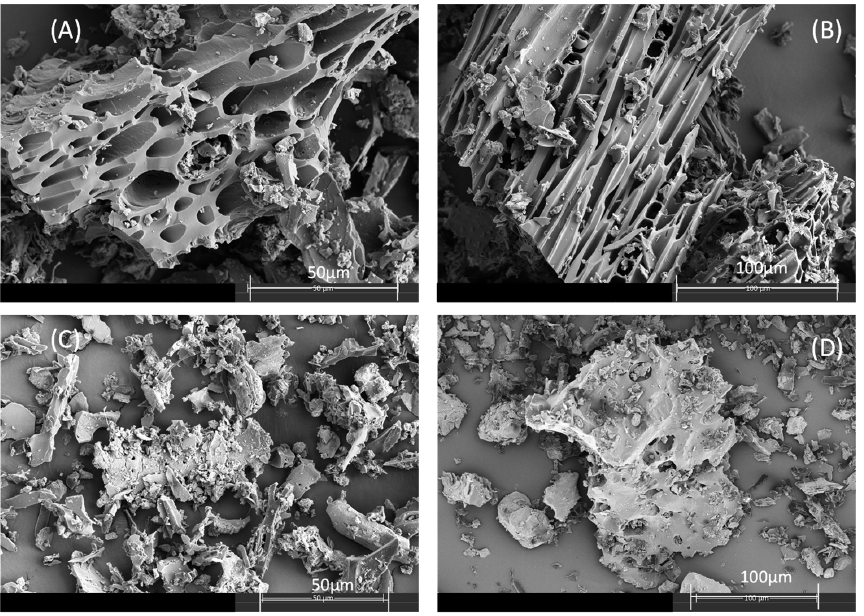
Figure 1. SEM visualization of individual biochar sample, ( A ) and ( B ) photographs correspond to BC and ( C ) and ( D ) with BC-Fe. ( C , D ) with